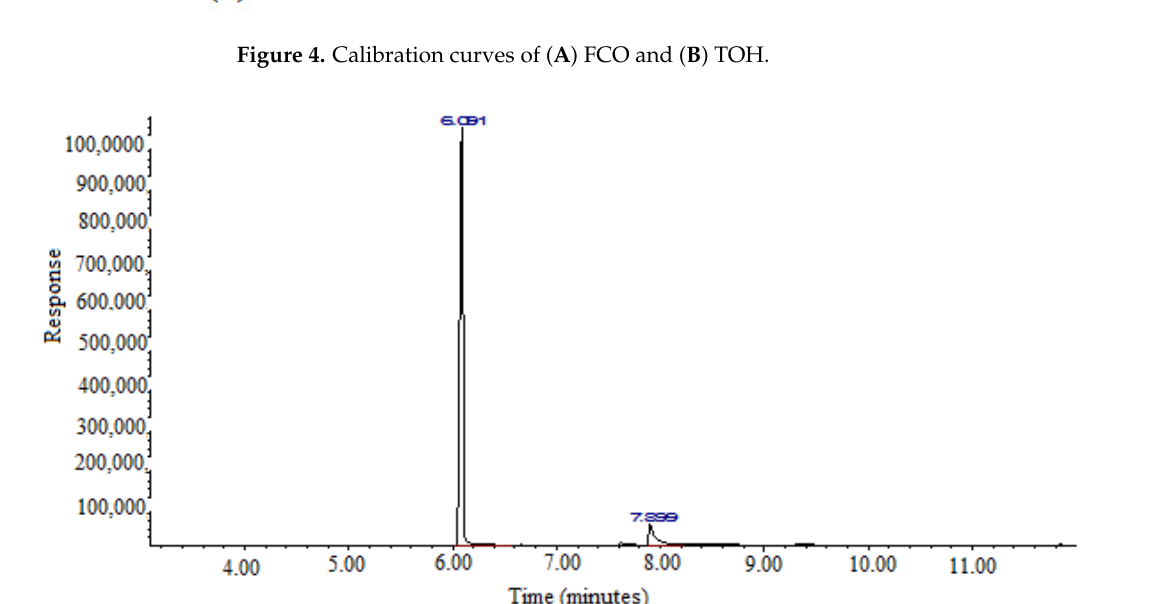
Figure 5. Gas chromatography–mass spectrometry (GC-MS) peaks of standard FCO (R t = 6.091 min) and TOH (R t = 7.889 min).